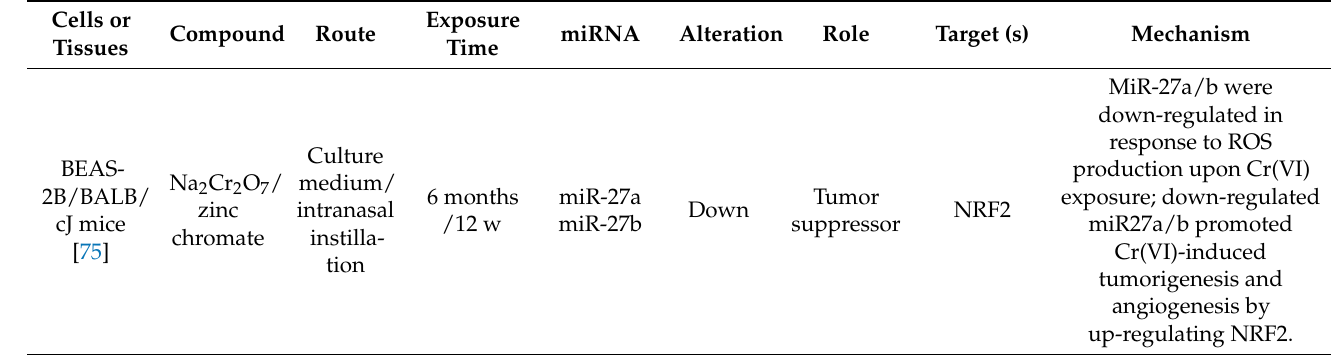
Table 3. Roles of altered miRNA in Cr(VI) exposure-induced